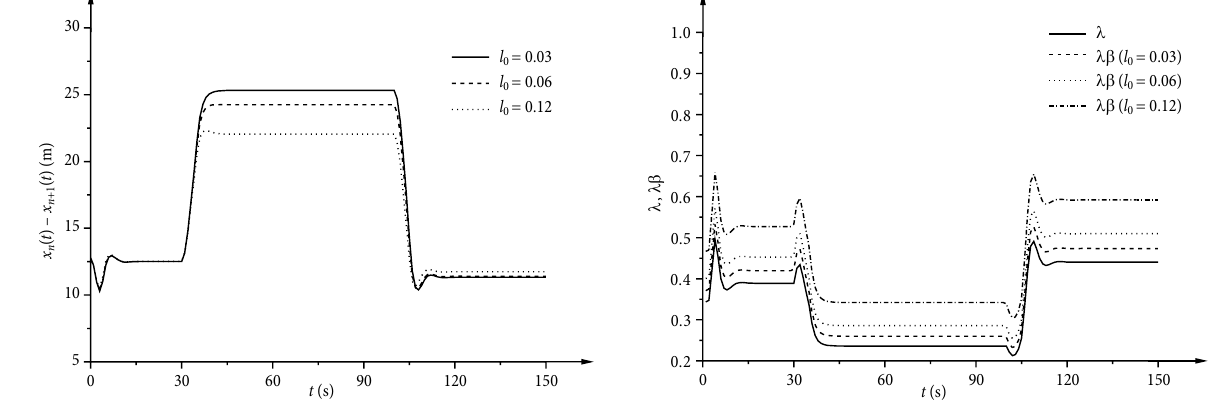
Fig. 5. Profiles of the distance headways between the lead and following vehicles based on the settings in Ex. 6